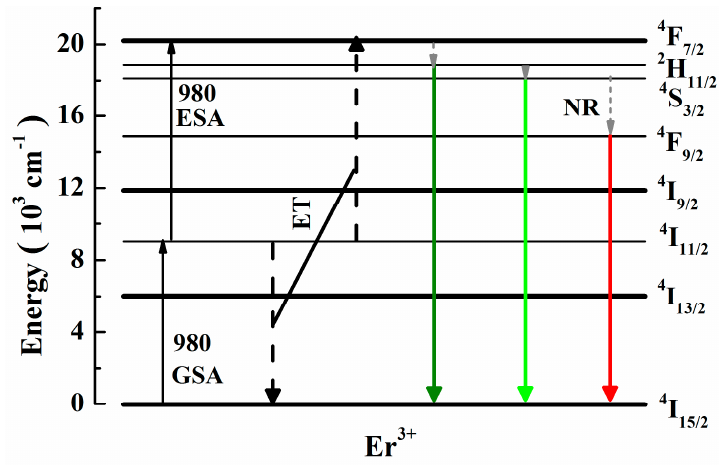
Figure 8. Schematic energy-level diagram of Er 3+ ions in PEN-PMN-PT and up-conversion process.